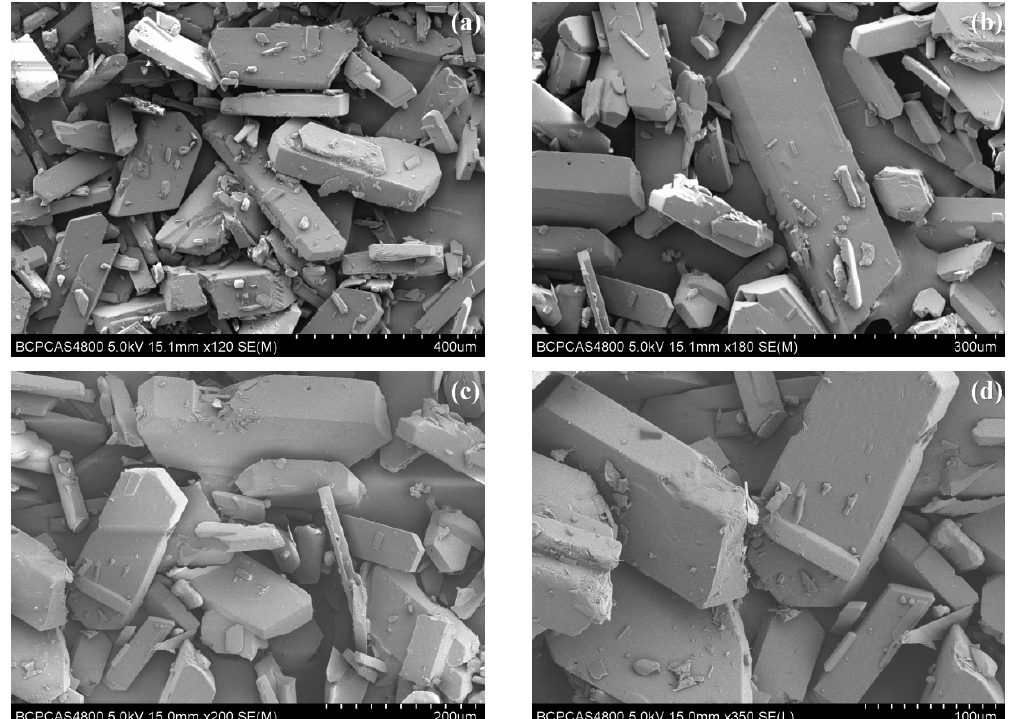
Figure 2. Crystal morphology of ATRZ characterized by SEM. 400 μ m ( a ), 300 μ m ( b ), 200 μ m ( c ), and 100 μ m ( d ).